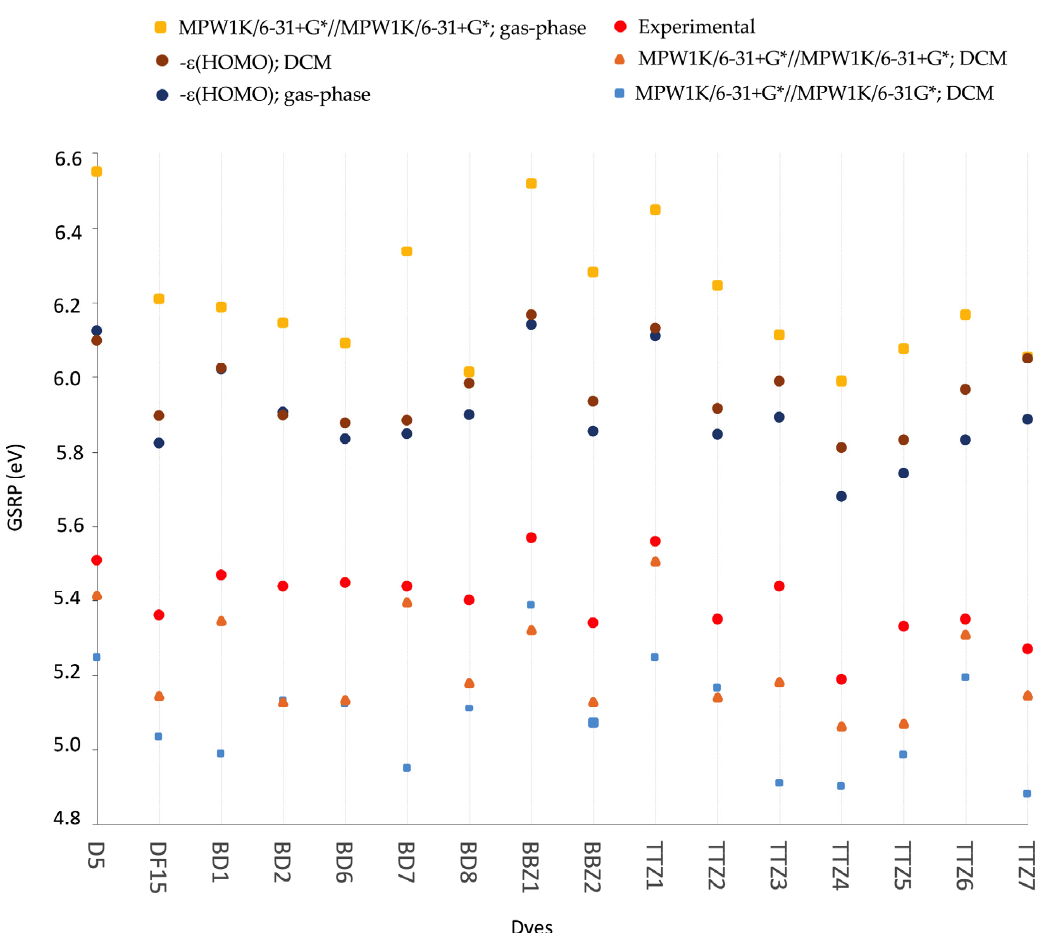
Figure 5. Experimental, computed GSRP and − ε (HOMO) of dye sensitizers.